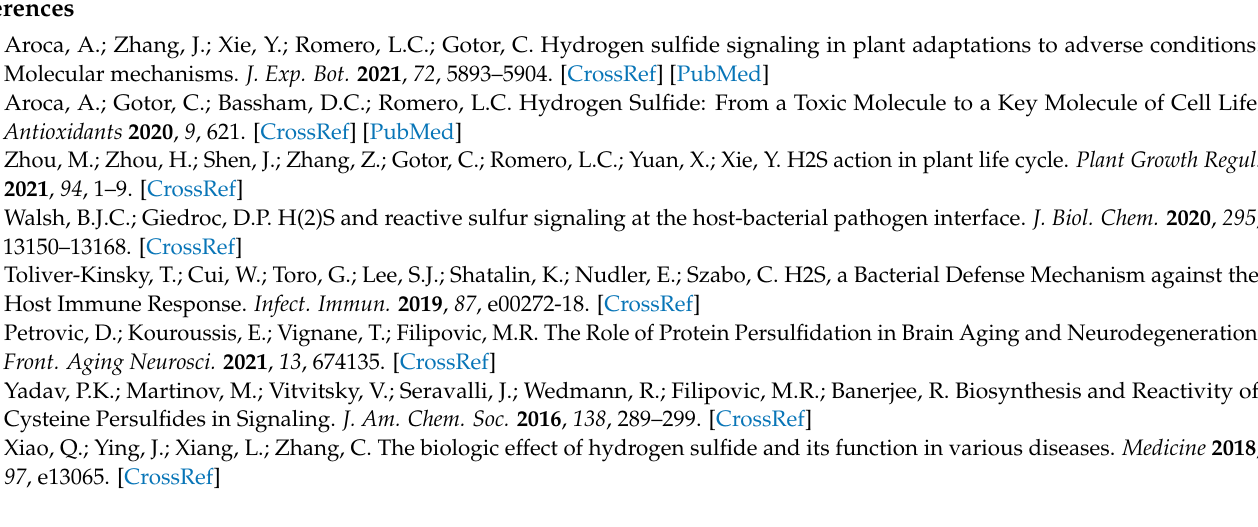
Figure S3: Hierarchical clustering of persulfidated proteins in severe C-starved samples and C-starved samples after recovery; Table S1: Identified proteins in cluster D1 related to the GO_BF term protein folding; Table S2: Identified proteins in cluster D2 related to carbon metabolism; Table S3: Identified proteins in light clusters according to GO_BF and KEGG